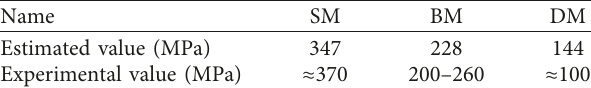
Figure 7: Experimental stress-strain curve of a milled baseline specimen (BM) with the predicted onset of plastic tow straight- ening (circle) and the initial stiffness (thin straight line) indicated. Table 3: Experimentally determined and estimated stress levels where the onset of plastic tow straightening